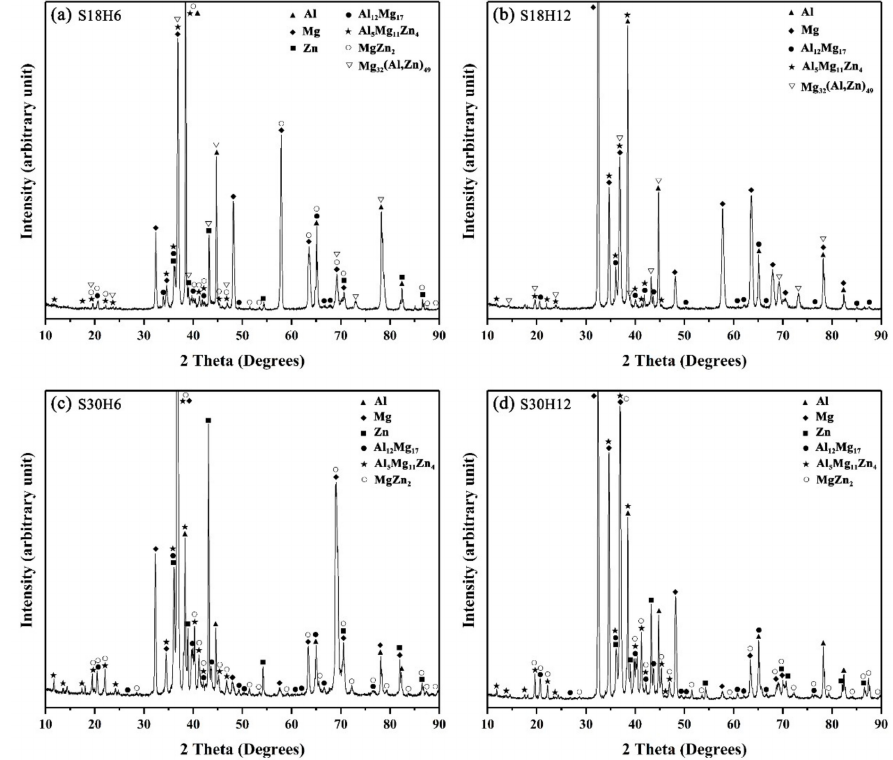
Figure 10. XRD pattern of the constituent phases at the interface of the arc-sprayed Al / AZ91D with a Zn interlayer: ( a ) S18H6, ( b ) S18H12, ( c ) S30H6, and ( d )